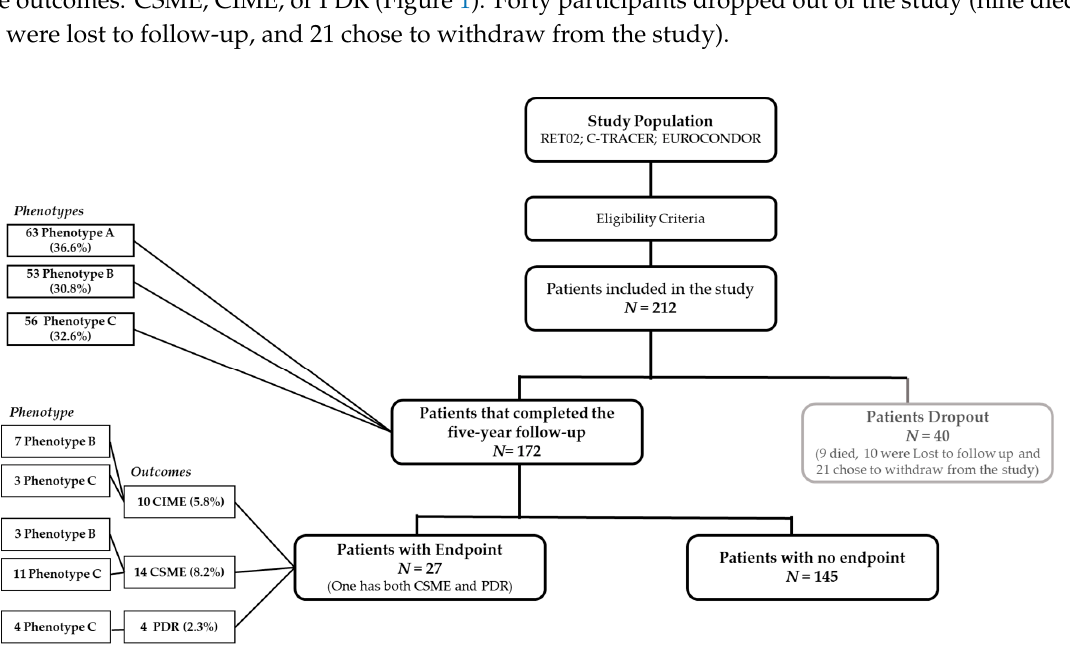
Table 1. Demographic and clinical characteristics.